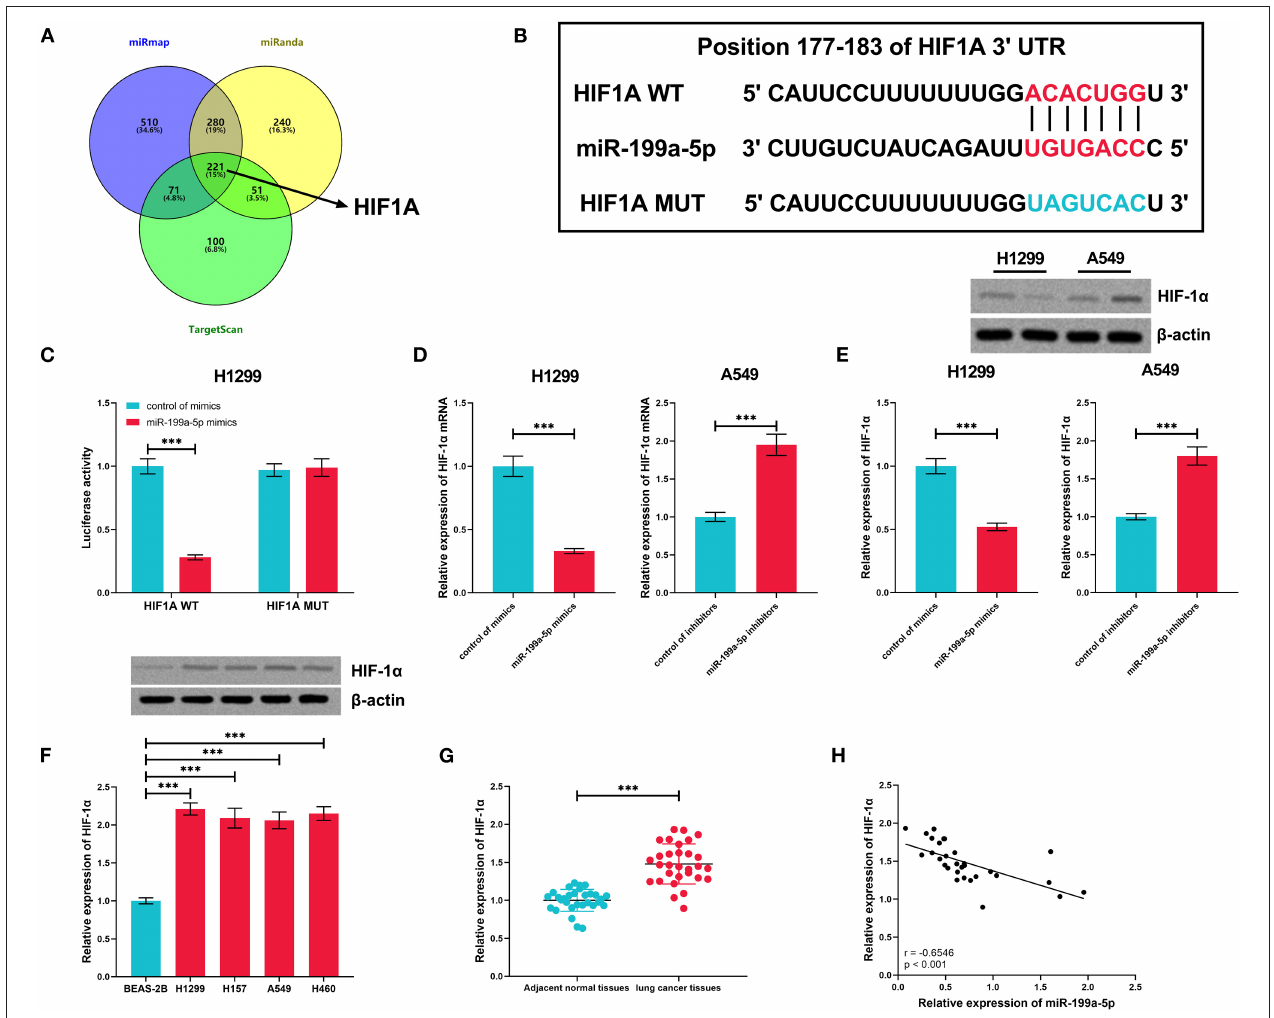
FIGURE 5 | HIF1A was regulated by miR-199a-5p in NSCLC cells. (A) Potential downstream target genes of miR-199a-5p were co-predicted with the miRmap, miRanda, and TargetScan databases. (B) Conserved binding sequence between HIF1A 3 ′ UTR and miR-199a-5p. (C) Dual-luciferase reporter assay was performed to verify the predicted binding site between miR-199a-5p and HIF1A 3 ′ UTR. (D,E) qRT-PCR and Western blotting were conducted to measure the expression of HIF1A mRNA and HIF1A protein in H1299 and A549 cells after the transfection of miR-199a-5p mimics or inhibitors. (F) Western blotting was performed to measure HIF-1 α protein expression in NSCLC cell lines. (G) Expression of HIF-1 α in 30 pairs of NSCLC tissues and adjacent normal tissues was detected by qRT-PCR. (H) Correlation between HIF-1 α expression and miR-199a-5p expression in NSCLC tissues. All of the experiments were performed in triplicate. *** p <